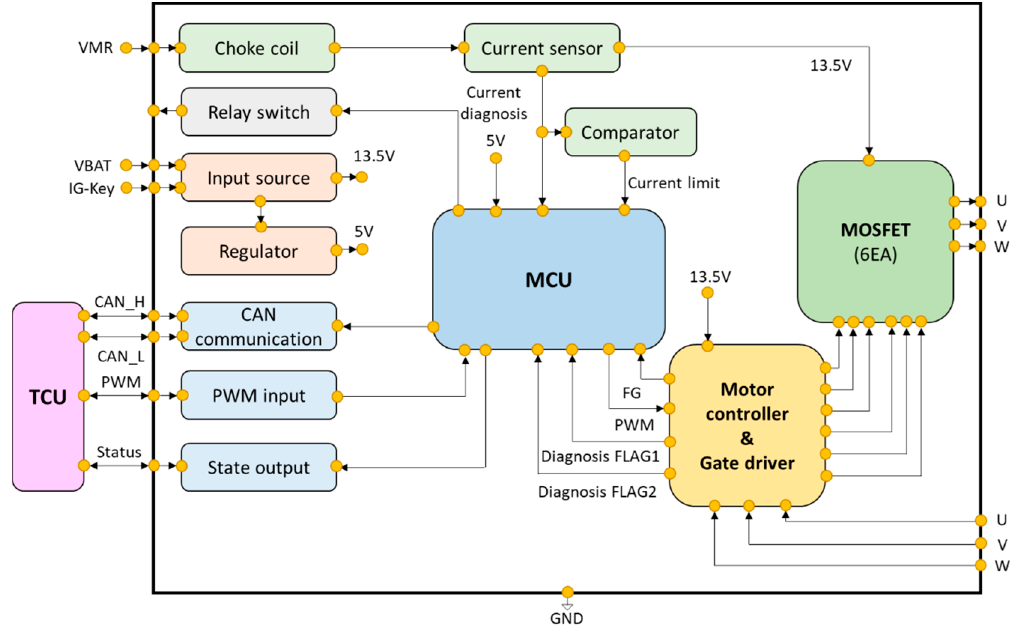
Figure 2. Block diagram of the EOP control unit.